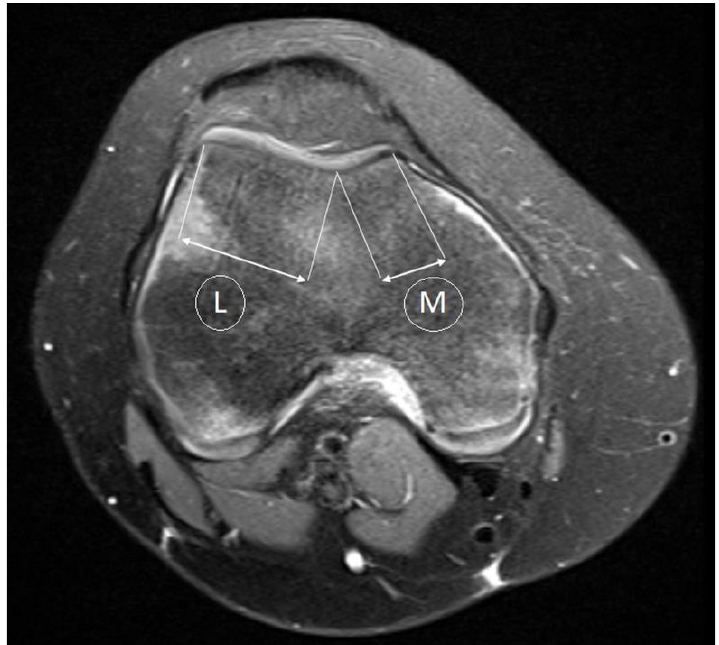
Figure 2. Trochlear facet asymmetry, ratio of length of medial trochlea to length of lateral trochlea. L — lateral, M — medial.